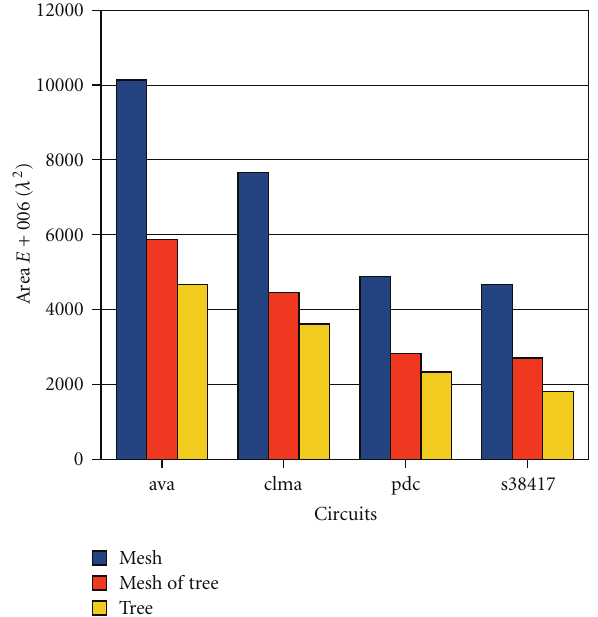
Figure 23: Comparison of various FPGA architectures